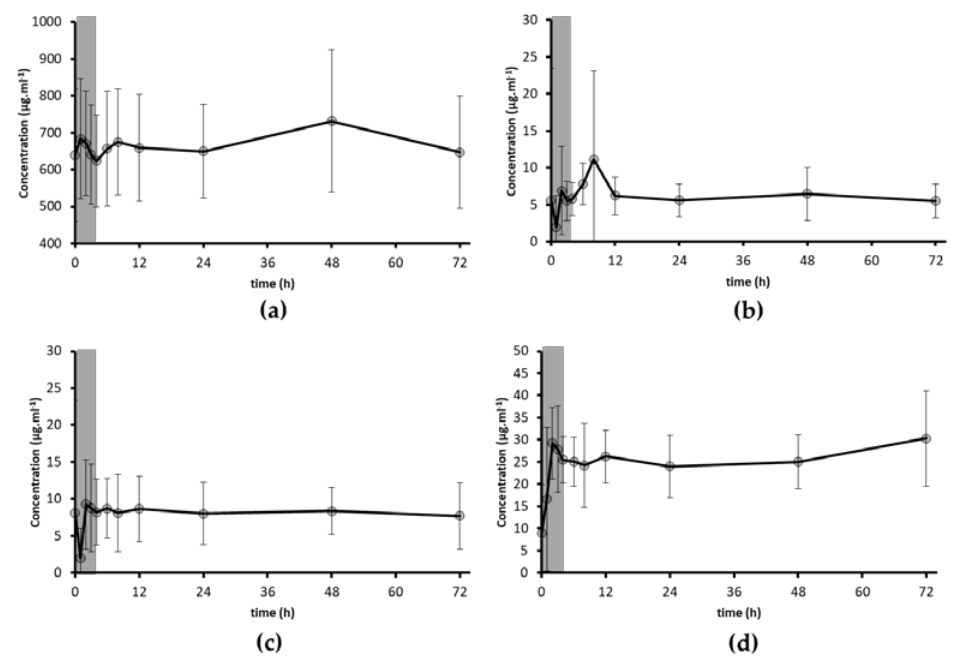
Figure 3. Average profile of plasma concentrations of linoleic acid ( a ), α -linolenic acid ( b ), EPA ( c ) and DHA ( d ) for the 11 volunteers. Grey area represents the first 4 h after microalgae intake. Error bars represent SEM.